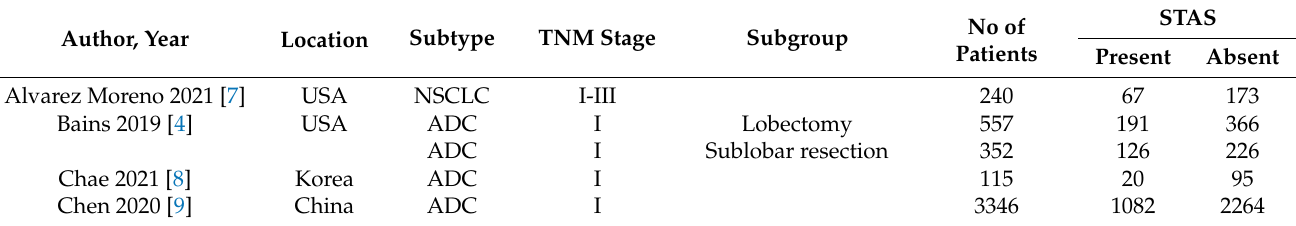
Table 1. Main characteristics of eligible